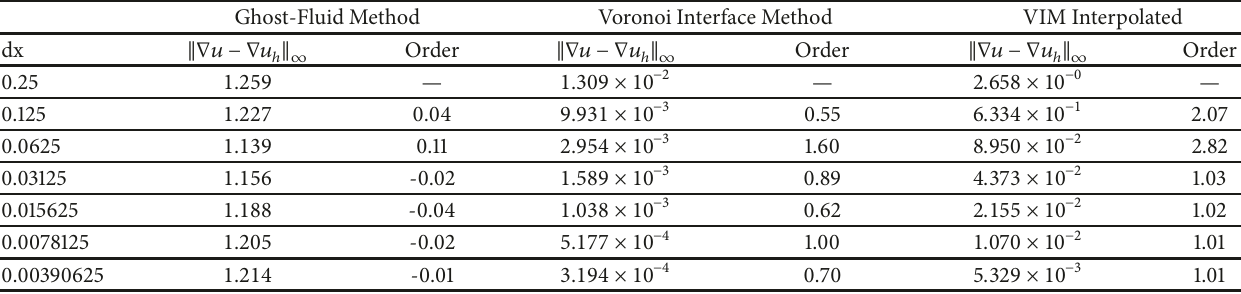
Table 7: Comparison of the 𝐿 ∞ error in the gradient of the solution for the Ghost-Fluid Method and the Voronoi Interface Method, for example, shown in Section